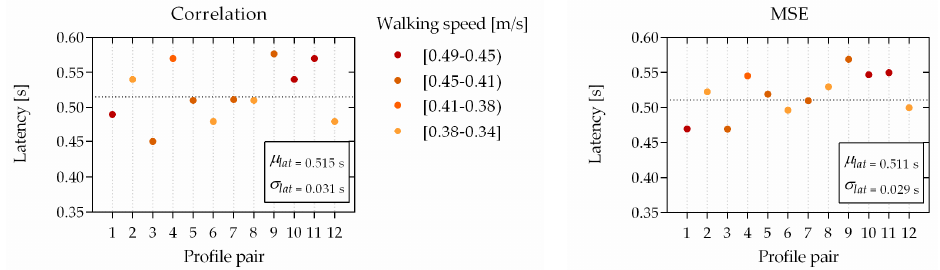
Figure 9. Presentation of the estimated latency within the 12 pairs of profiles with two fidelity measures using 400 MHz antenna. The colour chart shows the mean walking speed of each pair of profiles. The mean latency µ lat and the standard deviations σ lat for both fidelity measures are presented.